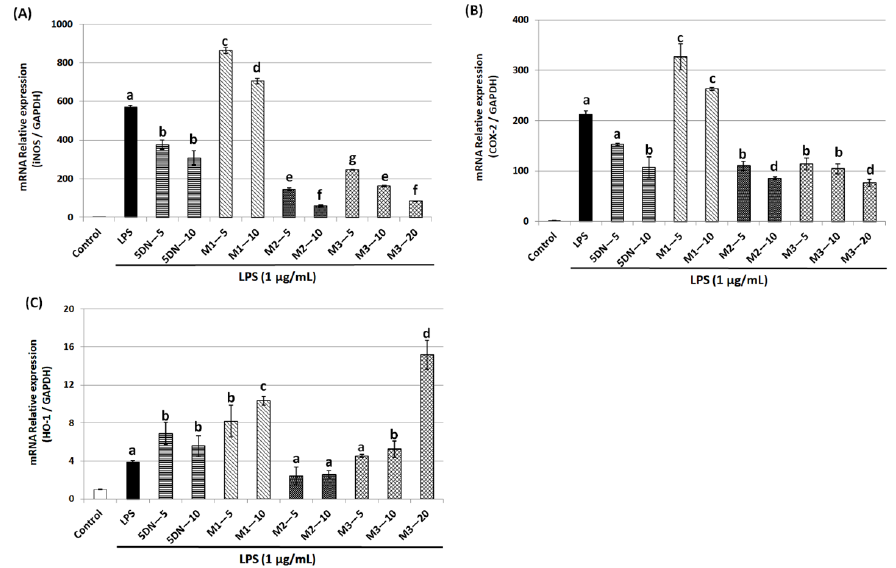
Figure 3. Effects of 5DN and its metabolites M1, M2, and M3 on the mRNA levels of iNOS ( A ), COX-2 ( B ), and HO-1 ( C ) in LPS-stimulated RAW 264.7 macrophages. Relative iNOS, COX-2, and HO-1 mRNA expression (2 − ∆∆ Ct ) was determined by real-time PCR and calculated by the Ct value for iNOS, COX-2, and HO-1 from GAPDH mRNA. ∆∆ Ct = (C t target gene -C t GAPDH )-C t control -C t GAPDH ). Each value represents the mean ± SD. Different superscript letters in each column indicate significant differences between groups ( p < 0.05, n = 3) by one-way ANOVA and Tukey’s post hoc